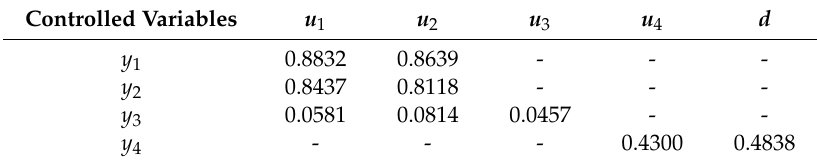
Table 2. The value of µ ij (“-” means µ ij is too small and can be ignored).